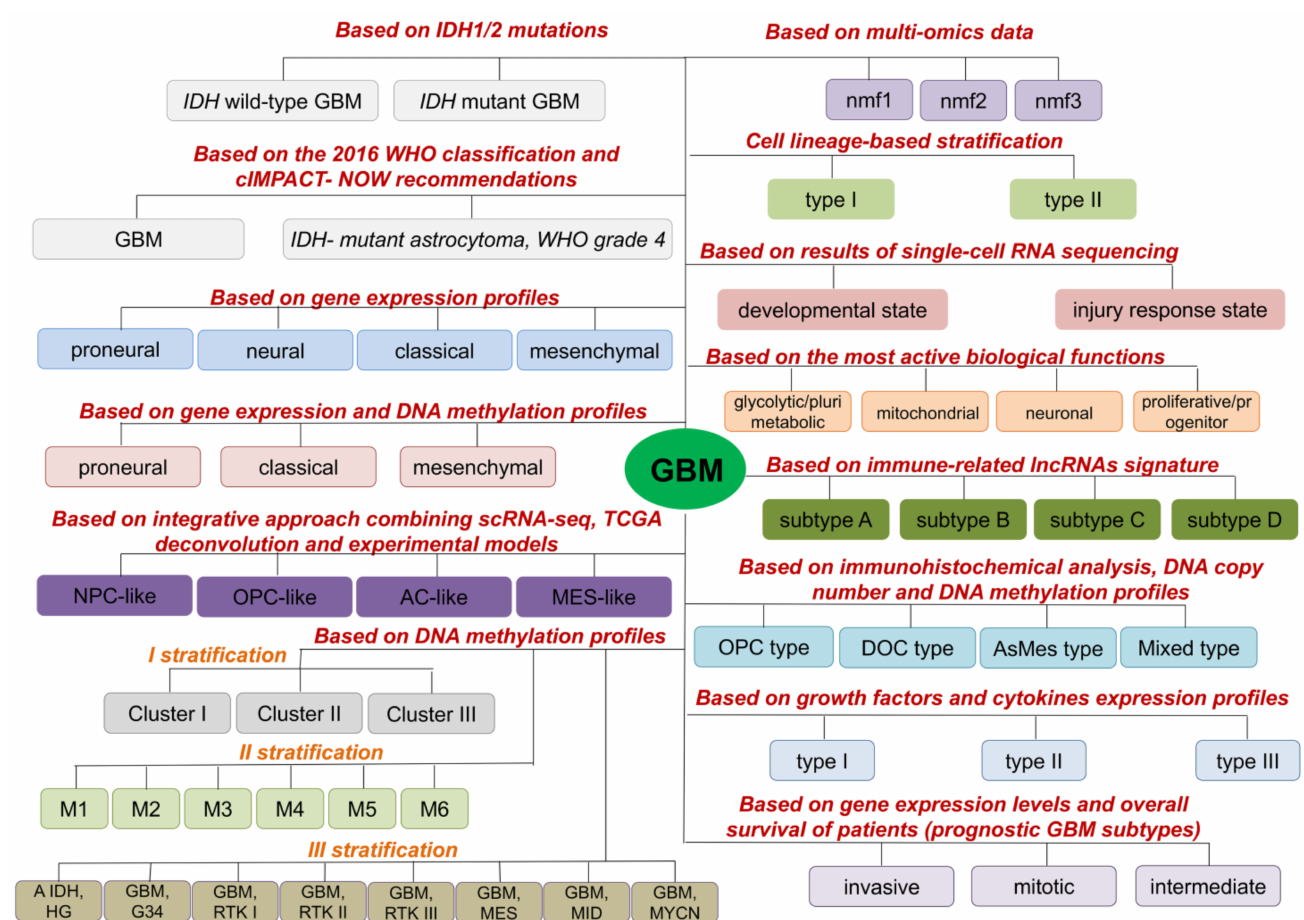
Figure 1. Stratification of GBM into subtypes. This summary is based on the previously reported publications listed in the main text and in Supplementary Table